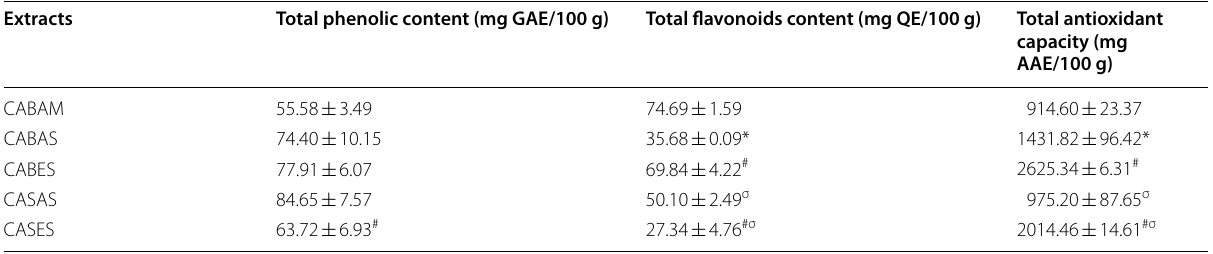
Values represent Mean Standard Deviation ( n 3). * p < 0.05 versus maceration; # p < 0.05 versus acetone; σ p < 0.05 versus ± =